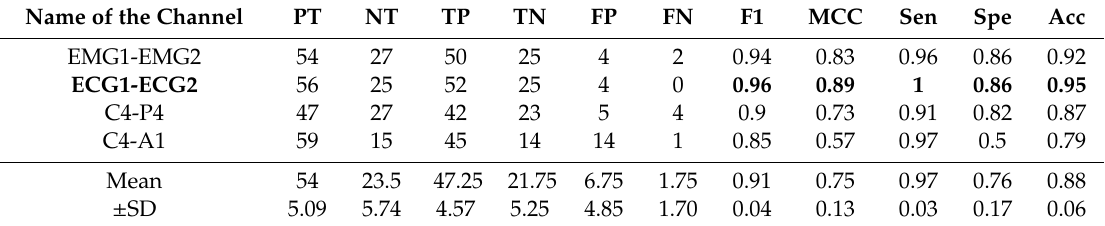
Table 3. Performance of the sleep stages (w and REM) classification using the novel 20-fold cross-validation model of the HML classifier.